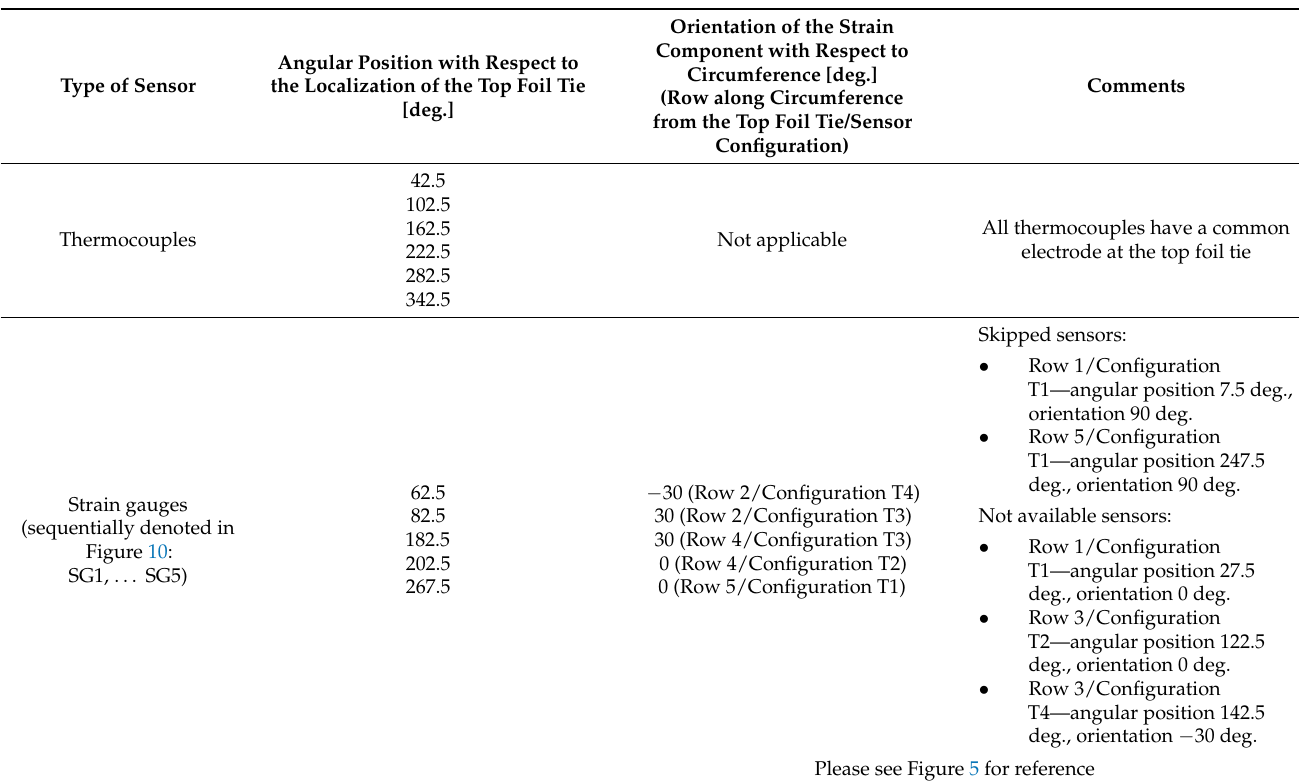
Table 2. Thermocouples and strain gauges centrally axially localized in the top foil used to collect measurement data for the current study.